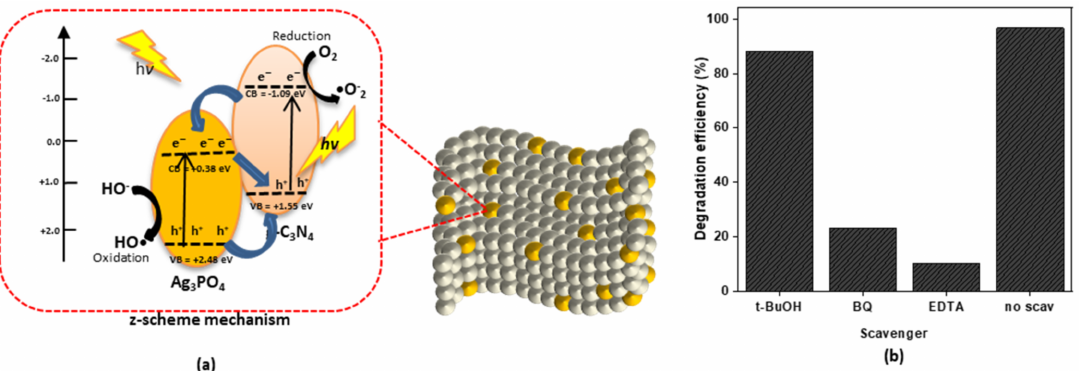
Figure 13. ( a ) Plausible mechanism of photodegradation of MO in the P-AgC (13%) composite film photocatalyst and ( b ) effect of radical scavengers ( tert -butanol, p -benzaquinone, sodium EDTA) toward degradation efficiency of